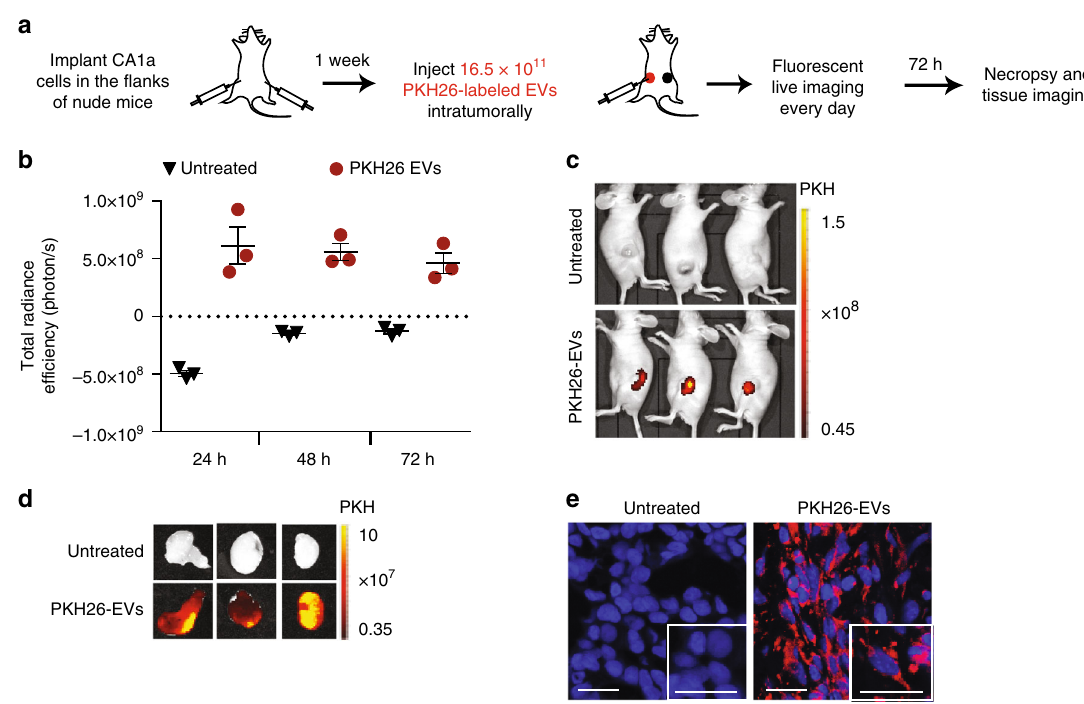
Fig. 4 RBCEVs are taken up by breast cancer cells in vivo. a Schema of an in vivo EV uptake assay. b Total radiance ef fi ciency of PKH26 fl uorescence in the tumors 24 to 72 h after an intratumoral injection of 16.5 × 10 11 PKH26-labeled RBCEVs, determined using an in vivo imaging system (IVIS), presented as mean ± SEM ( n = 3 mice). c Images of the mice bearing untreated tumors on the right fl ank and tumors injected with PKH26 -labeled EVs on the left fl ank, 72 h post-treatment, captured using IVIS. PKH26 is shown in pseudocolored radiance. d Images of the tumors excised from the mice in c . e Representative confocal microscopy images of tumor sections with DAPI stained nuclei and PKH26 signals from the cells with EV uptake. Scale bar, 20 µ